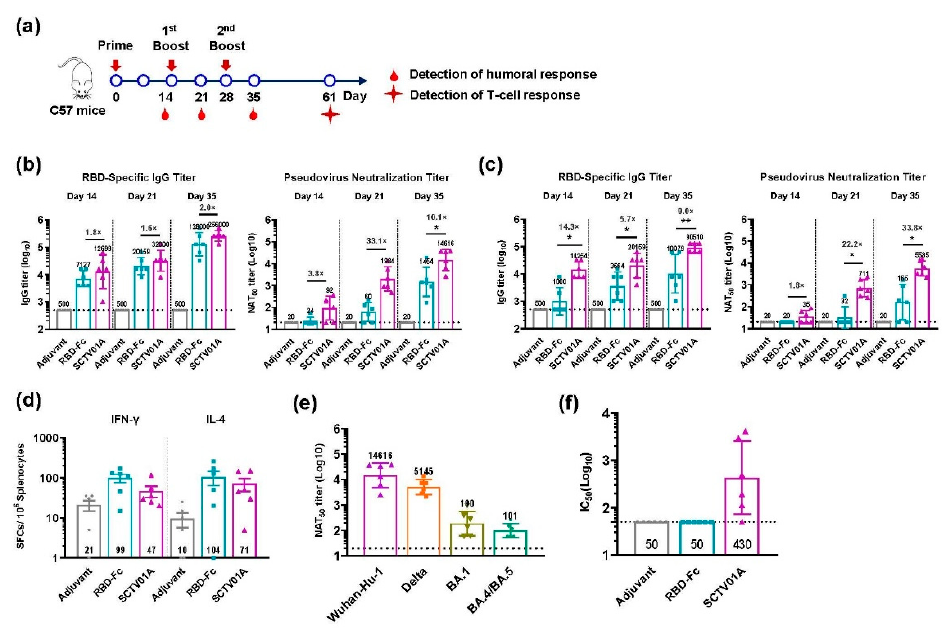
Figure 2. SCTV01A enhances RBD-Fc-specific immune responses in C57BL/6 mice. ( a ) Schematic diagram of immunization and sample collection. C57BL/6 mice (n = 6/group) were intramuscularly immunized with 3 µ g of SCTV01A or RBD-Fc formulated with SCT-VA02B or Alum adjuvant three times with a 14-day interval. ( b ) RBD specific IgG titer and NAT 50 titer formulated with SCT-VA02B. ( c ) RBD specific IgG titer and NAT 50 titer formulated with Alum. ( d ) The frequencies of RBD-specific IFN- γ - and IL-4-SFCs in total splenocytes were determined by ELISpot formulated with SCT-VA02B. ( e ) NAT 50 titer against the Delta, BA.1, and BA.4/BA.5 variants of SCTV01A formulated with SCT-VA02B at Day 35. ( f ) OPA of SCTV01A-immunized sera as determined by opsonophagocytic assay formulated with SCT-VA02B at Day 35. The GMT of RBD-specific antibody titer and NAT 50 titer against the Wuhan-Hu-1 strain were determined by ELISA and SARS-CoV-2 PsV neutralization assay. The dashed black lines indicate the limit of detection (LOD). The LOD of the RBD-specific antibody ELISA is 500, and the LOD of the SARS-CoV-2 PsV neutralization assay is 20. For detection of the T-cell response, mice were euthanized at 61 days post first immunization, and their spleens were dissected for ELISpot. For ( b , c ), levels of RBD-specific IgG titers and NAT 50 titers were compared across SCTV01A and RBD-Fc by unpaired two-tailed Welch’s tests. * p ≤ 0.05 and ** p ≤ 0.01 represent statistical significance. The unlabeled comparisons were not significant, with p ≥ 0.05.